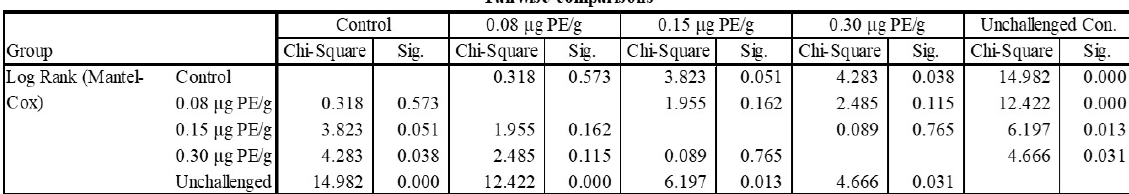
Figure 10. Effects of phycoerythrin (PE) on the survival rate of whiteleg shrimp ( Litopenaeus vannamei ) challenged with Vibrio parahaemolyticus during 72 h. The unchallenged control treatment was injected only with whiteleg shrimp saline solution (SSS), while other groups received SSS buffer containing 0, 0.30, 0.15, and 0.08 μ g of PE per gram of body weight prior to be challenged with Vibrio parahaemolyticus (1 × 10 6 CFU per shrimp). ( A ) Survivorship curves for whiteleg shrimp after challenged by V. parahaemolyticus . ( B ) Differences among the groups were assessed using the Mantel–Cox test for pairwise comparisons. Significant differences ( p < 0.05) are indicated by asterisks.